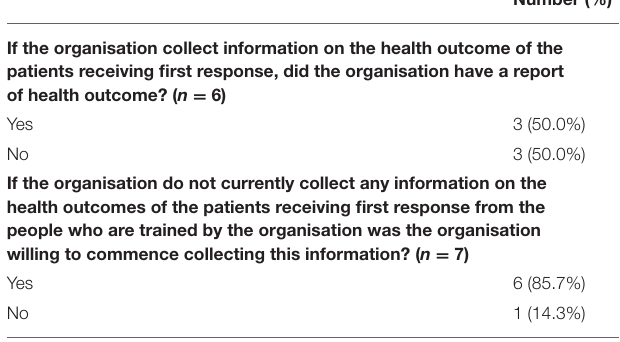
TABLE 4 | Information provided by organisations providing first aid training ( n =